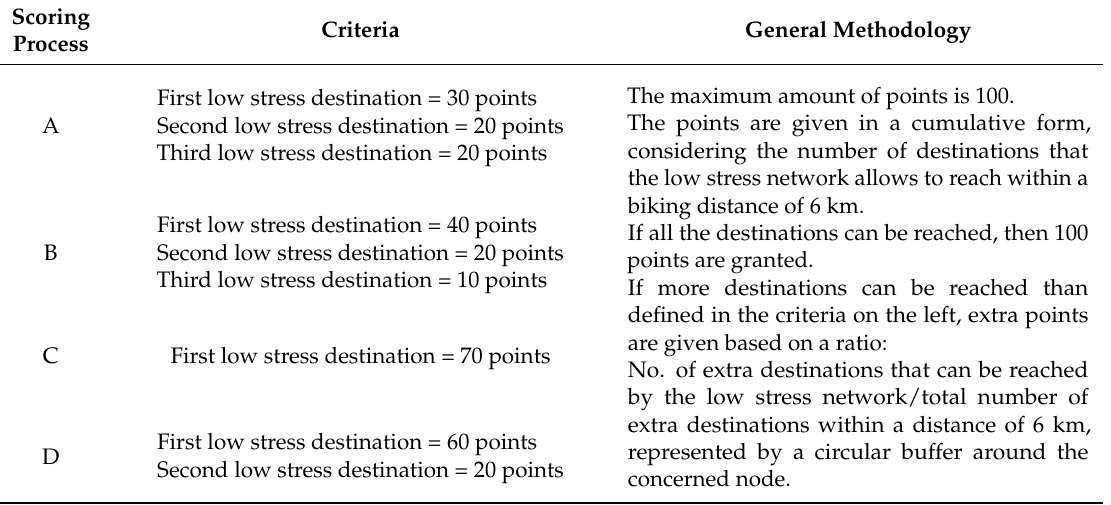
Table 2. Methodology for scoring